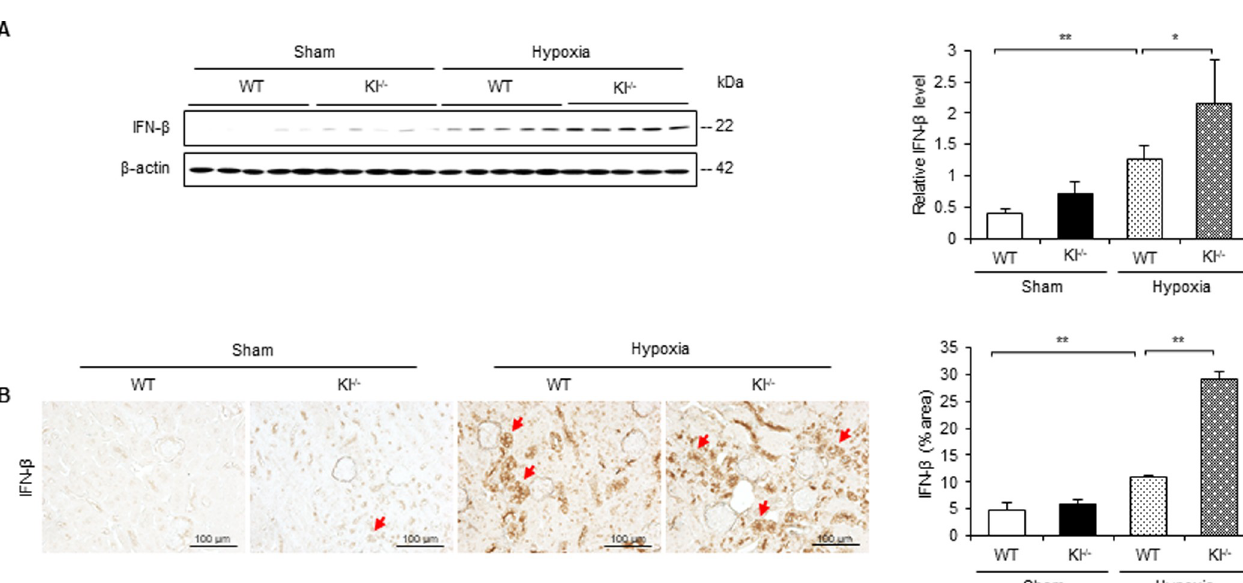
RIG-I was responsible for the expression of IFN- α / β in in vitro experiments. In human biopsy samples of IgA nephropathy, the expression level of RIG-I was shown to be positively corre- lated with that of IFN- α / β . In in vivo study, we found that the renal expression of klotho did not differ between WT mice with or without hypoxic stimulation. Klotho expression was not